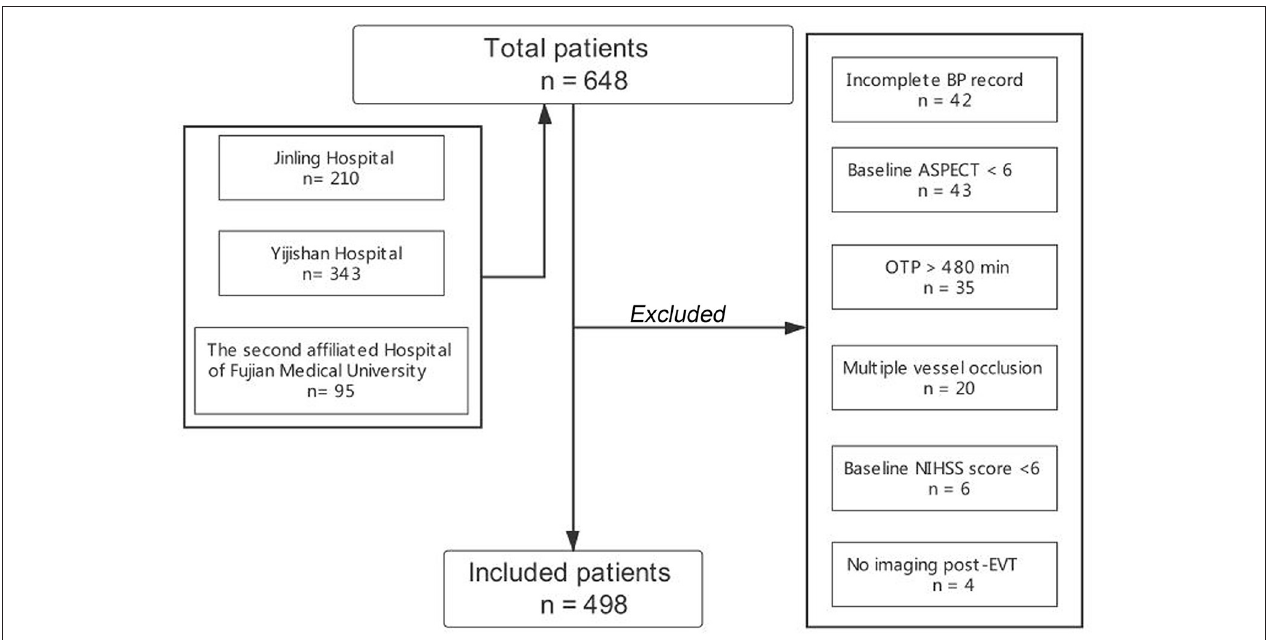
FIGURE 1 | Flow chart of the study